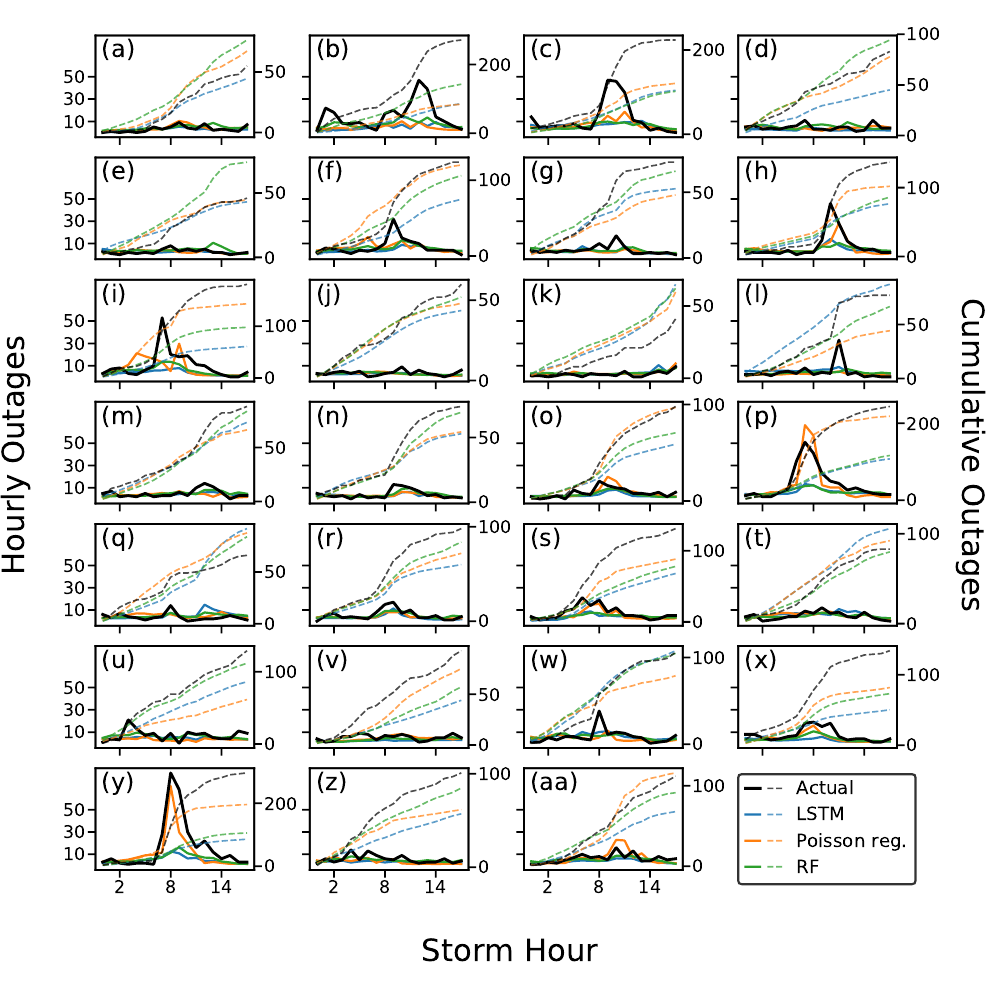
Figure 4. Hourly (solid) and cumulative (dashed) outages for 27 CT thunderstorms, each lasting 18 h, with corresponding LOSO cross-validated predictions by dynamic